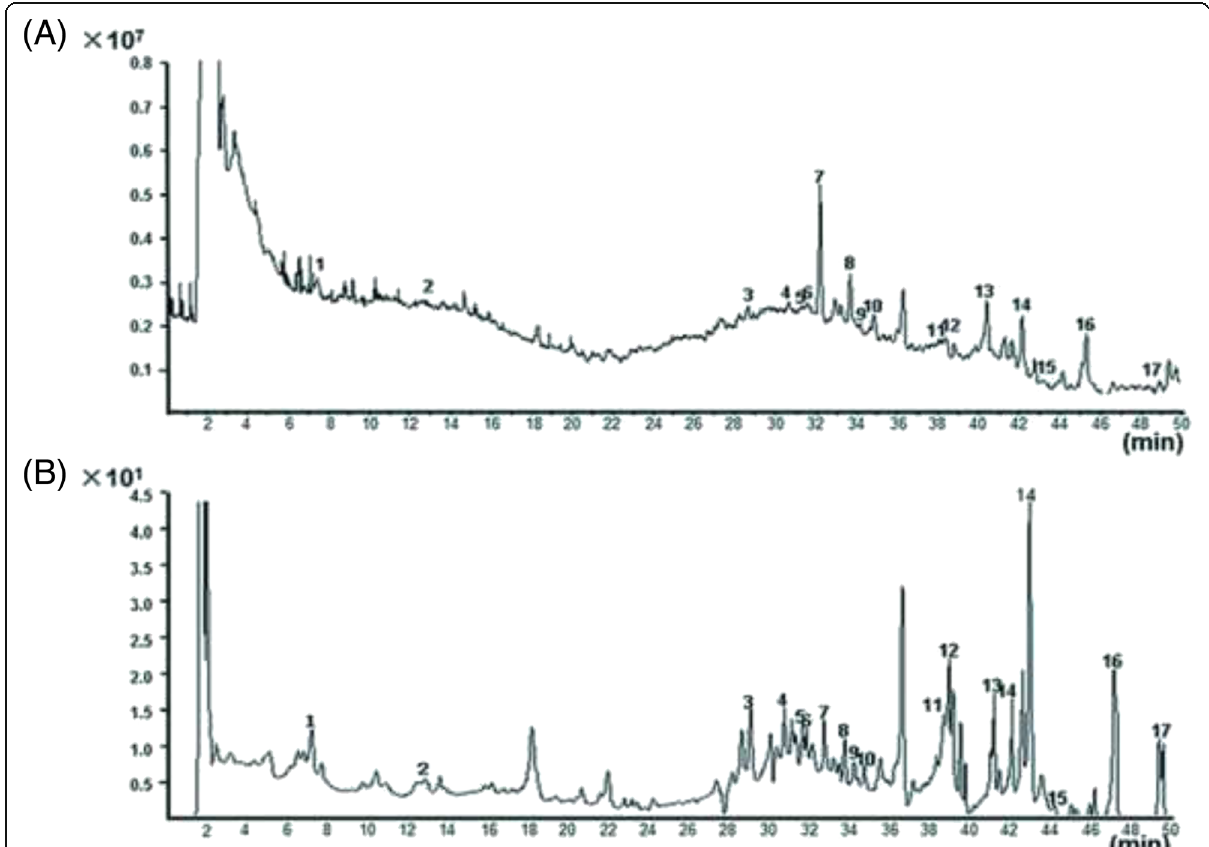
Fig. 2 TIC chromatogram and VU chromatogram of the extract of DHFZT in negative ion mode. ( a ) total ion current chromatogram, X-axis repre- sents the retention time (min), Y-axis represents ion intensity; ( b ) ultraviolet chromatogram, X-axis represents the retention time, Y-axis represents mAU. TIC total ion current, VU